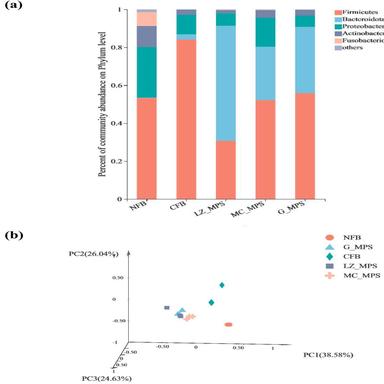
Compositions of gut microbiota. (a) Bacterial taxonomic profiling in the phylum level of gut microbiota, (b) Principal co-ordinates analysis plot, (c) Hierarchical clustering tree at phylum level, (d) OTU network plot (rectangles in the figure represent the different samples). NFB, without carbon source group; CFB, inulin treatment group; LZ_MPS, LZ-MPS treatment group; MC_MPS, MC-MPS treatment group; G_MPS, G-MPS treatment group.